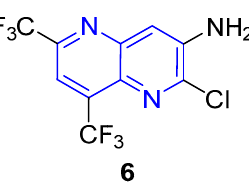
Figure 41. Compound with strong solvatochromic fluorescence.